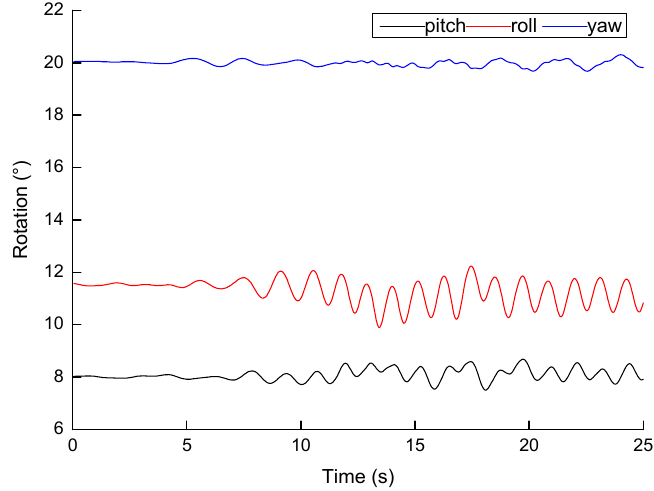
Figure 14. The angle variations of scheme 1 in the mooring experiment. 8.28 ◦ . The maximum yaw angle is approximately equal to 7.3 ◦ , and the average value is about 6.99 ◦